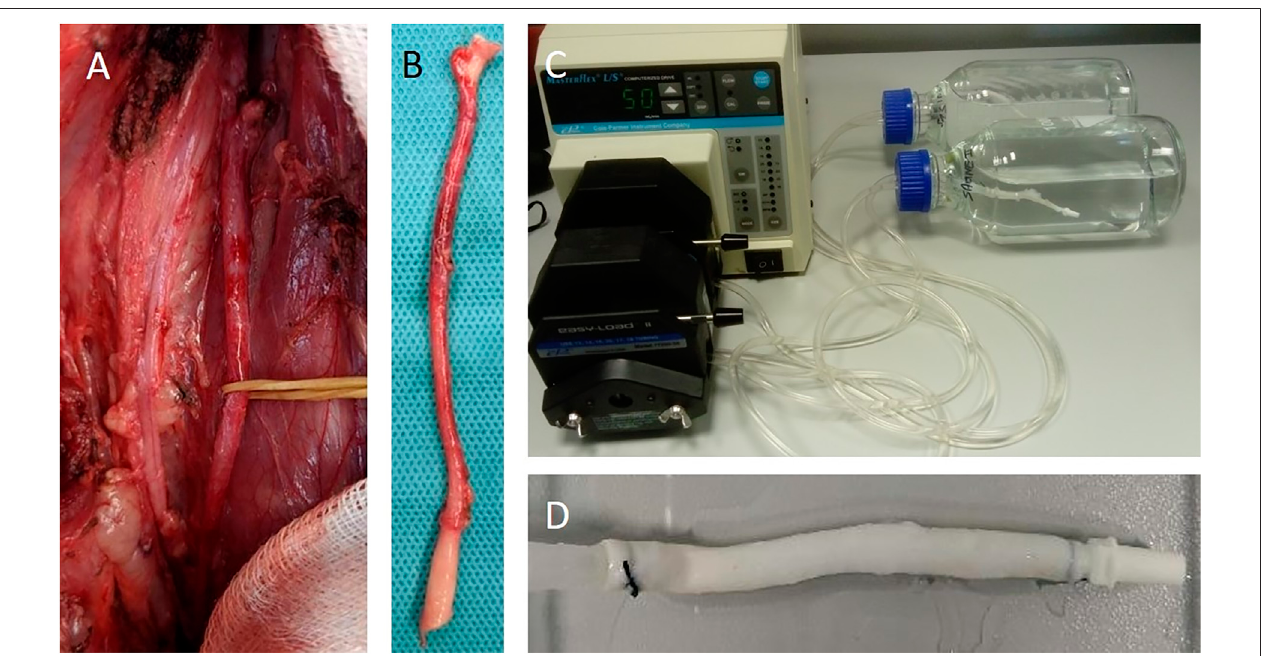
FIGURE 1 | Explant and decellularization of carotid arteries: (A) carotid artery identi fi ed in the animal before the explant, (B) explanted carotid artery – the proximal side is at the bottom of the picture, and it is identi fi able by its higher diameter if compared to the distal part that has the branches for the internal and external carotid arteries.Thedecellularizationsetupisshownin (C) ;themaster fl expumpspeedissetto50,butitscorrespondingvaluedependsonthetubetypeanddimensions;andin ourcase,itcorrespondsto250 ml/min.Thedecellularizedarteryscaffoldisshownin (D) .Thearteriesareexplantedfromtheanimalsandthenratherdecellularized within 24 h or stored for the long term at − 80 ° C in a cryoprotective